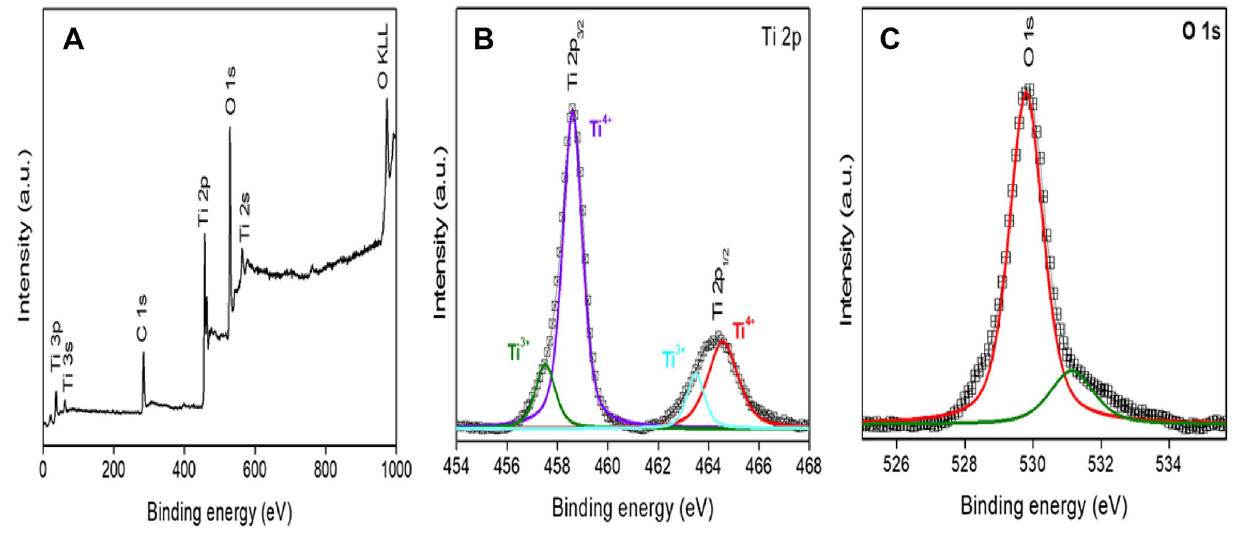
Fig. 2 XPS spectra for survey spectrum ( a ), Ti 2p ( b ) and O 1s ( c